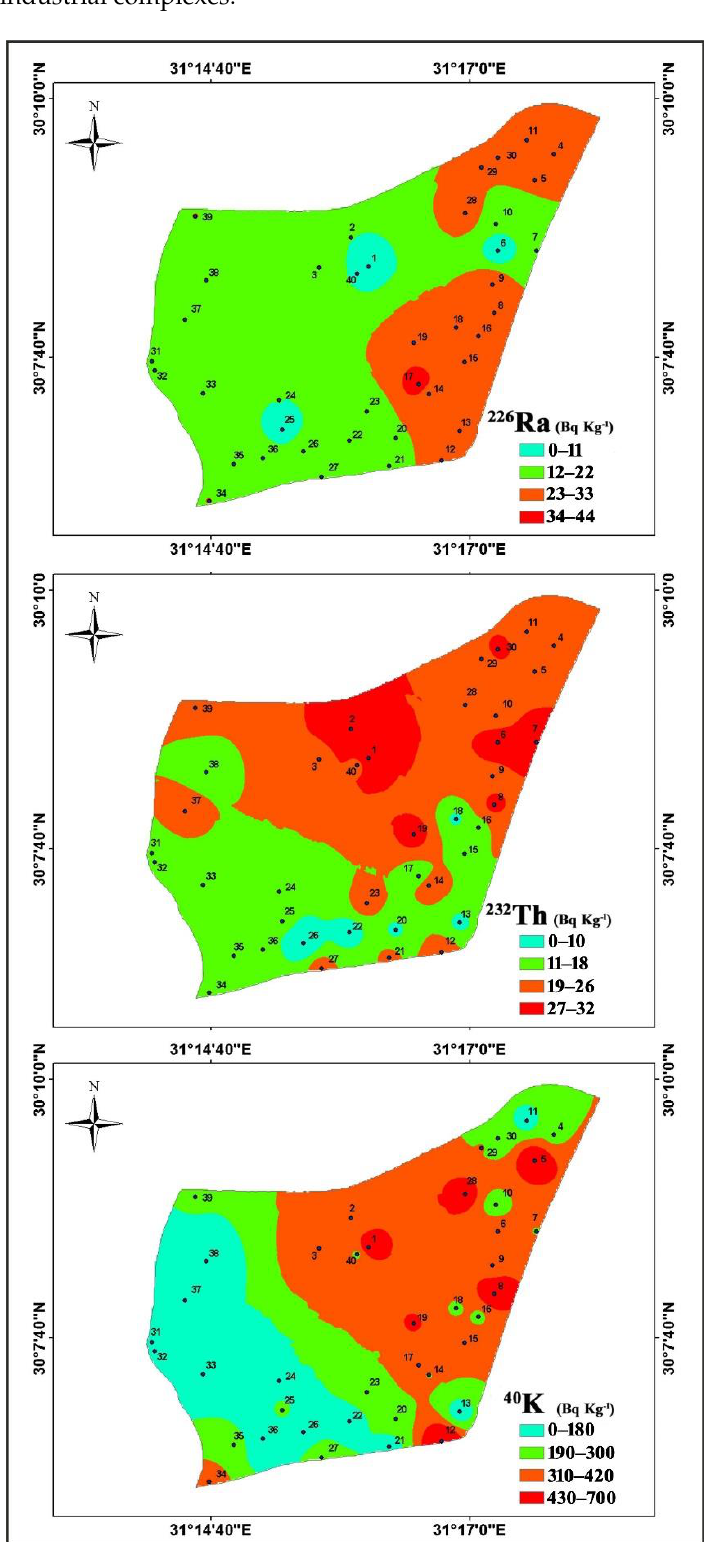
Figure 5. Spatial distribution maps of 226 Ra, 232 Th, and 40 K activity concentrations. The mean activity concentrations of 226 Ra and 40 K are higher in 20% of the studied samples than the world's average values (32, 45, and 412 Bq kg −1 , respectively) [4] (Figure 4). This indicates that the activity concentrations of 226 Ra and 40 K were affected to varying